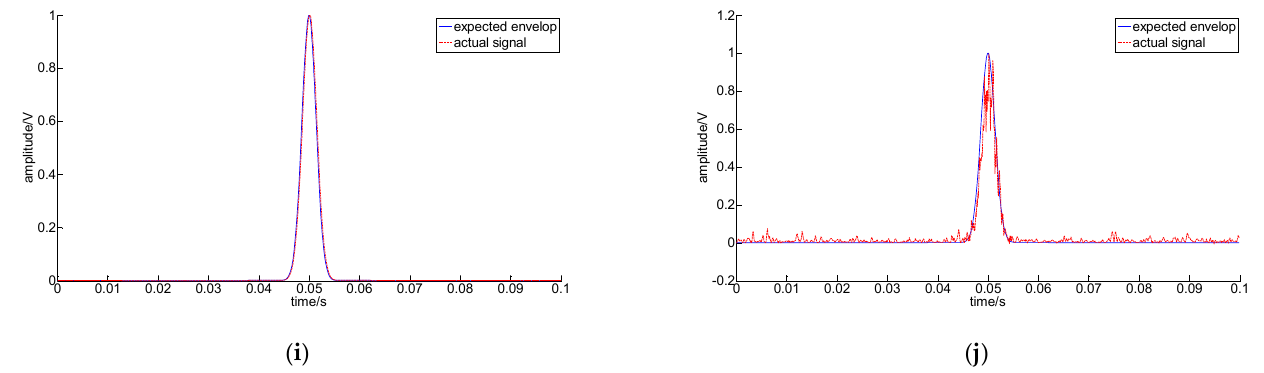
Figure 2. The TEO results of a noise-free impulse signal and a noisy impulse signal: ( a ) noise-free impulse signal; ( b ) impulse signal with noise; ( c ) normalized TEO result of ( a ); ( d ) normalized TEO result of ( b ); ( e ) normalized filtered TEO result of ( a ); ( f ) normalized filtered TEO result of ( b ); ( g ) normalized first derivative of the TEO result of ( a ); ( h ) normalized first derivative of the TEO result of ( b ); ( i ) normalized filtered first derivative of the TEO result of ( a ); ( j ) normalized filtered first derivative of the TEO result of ( b ).